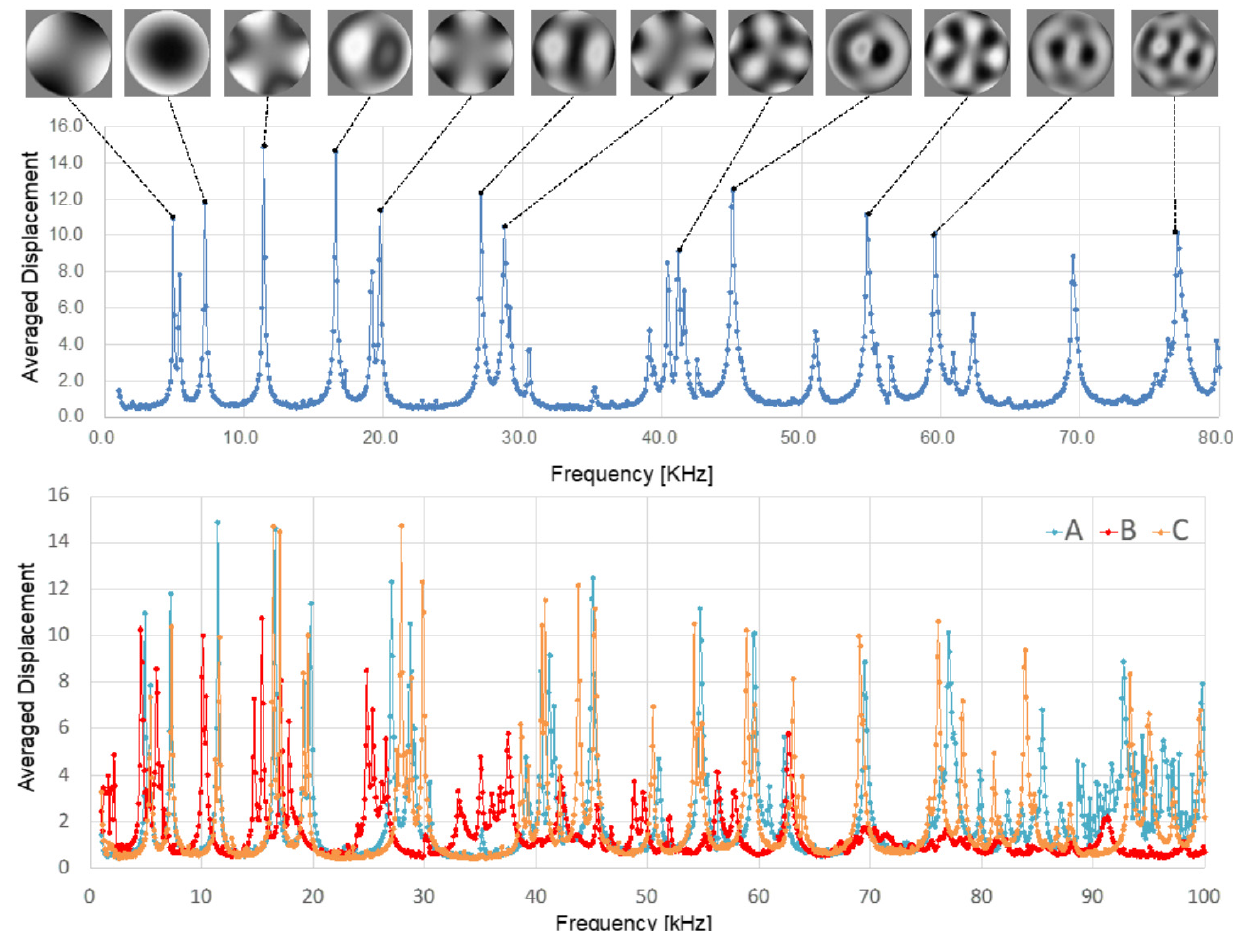
Figure 3. ( top ) Variation of vibration modes obtained from a single specimen. ( bottom ) The comparison of peak frequencies between specimens; A: undamaged specimen (no impact test), B and C: specimens subjected to impact test.